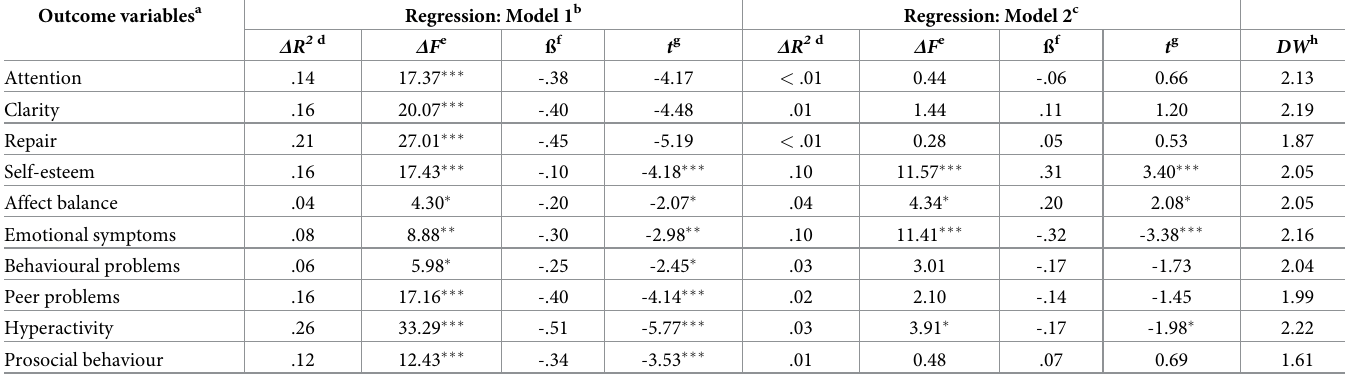
Predictor = pre-intervention score c Predictor = experimental condition, controlled for pre-intervention score d Change in R 2 e Change in F f Regression coefficient g Value of t-test statistic h Durbin-Watson test. � p �